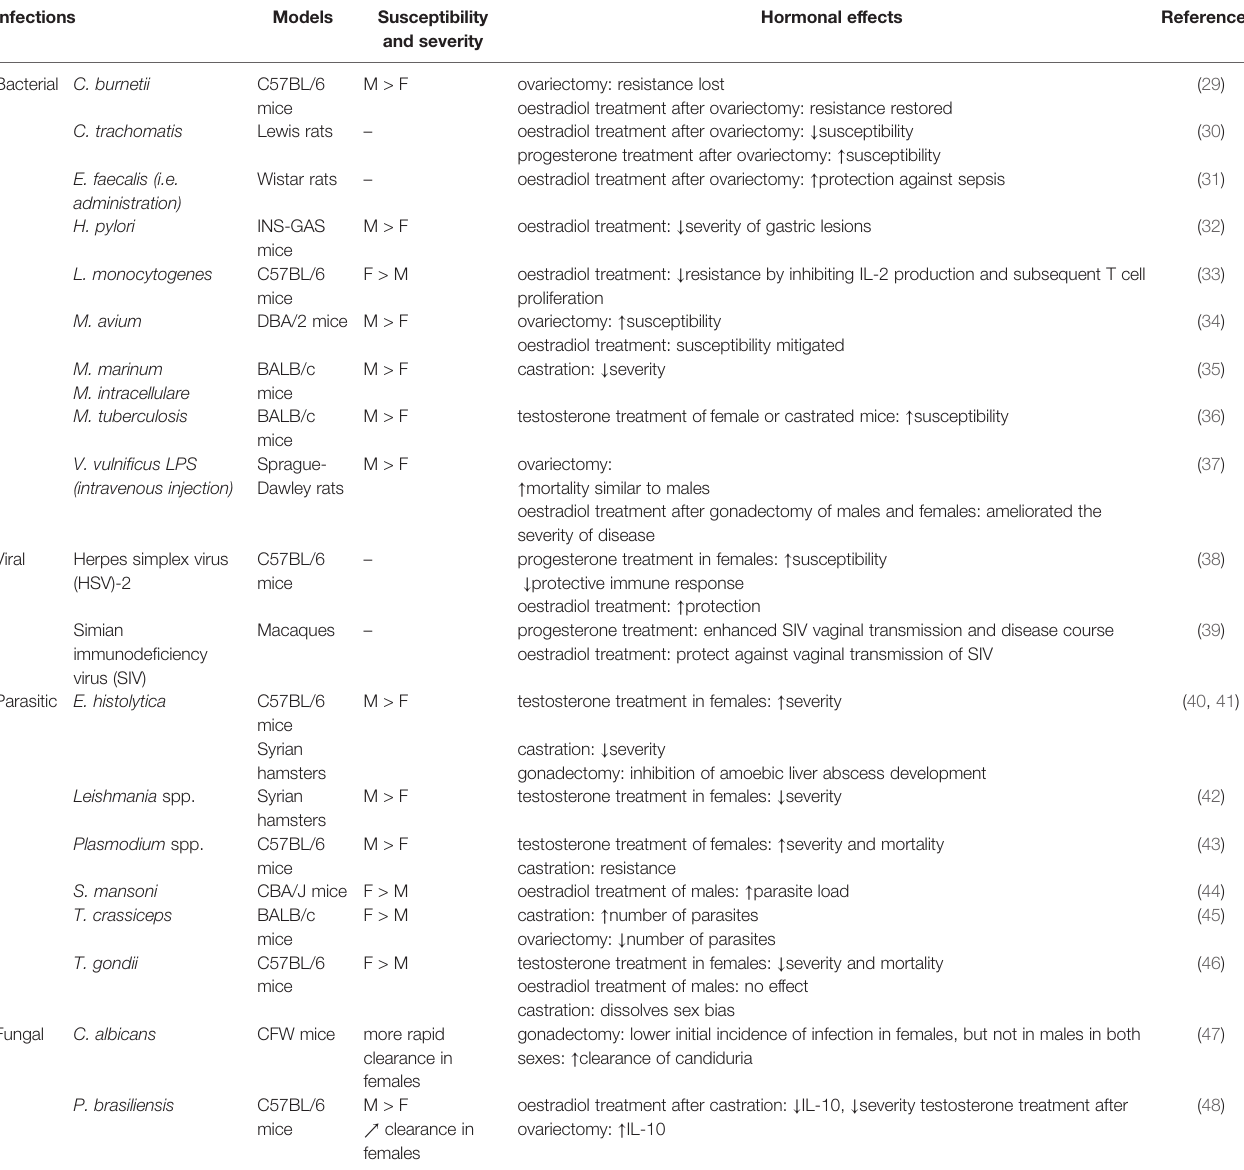
TABLE 1 | Effect of sex hormones on diseases in animal models.